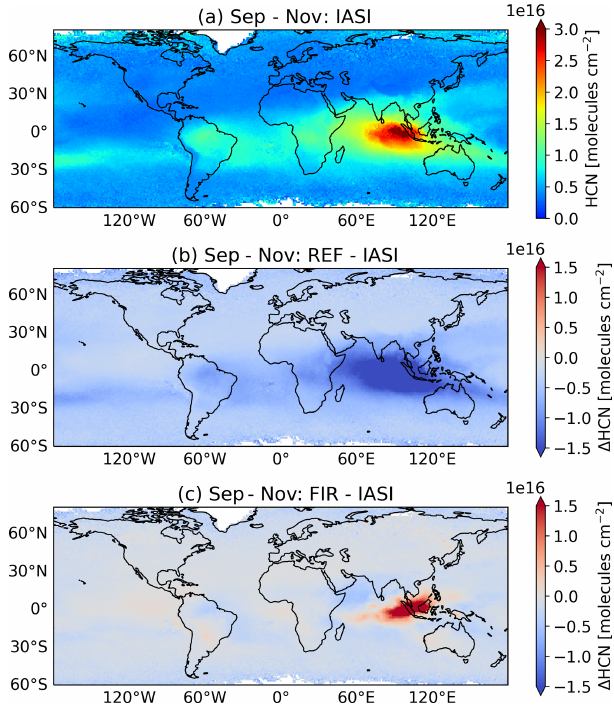
Figure 3. The total trace gas (VOC and non-VOC), the VOC, and the aromatic biomass emissions for each region in non-El Niño years, El Niño years, and in 2015 predicted by EMAC (based on REF LONG and FIR LONG ). Further details about each region are presented in Table 2 and Fig. 2.